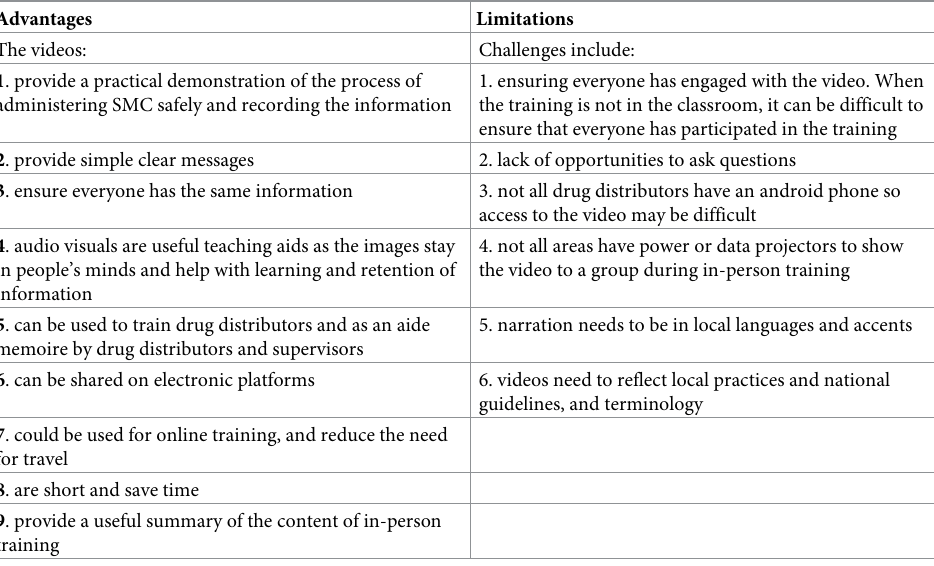
Table 2. Advantages and limitations of using the videos for